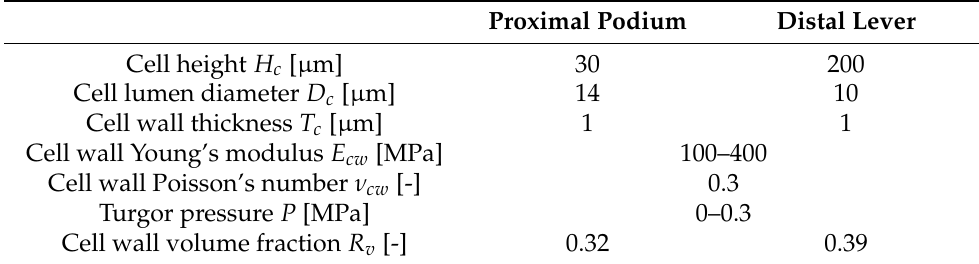
Table 3. Representative cellular features in the Finite Element Method (FEM) micro